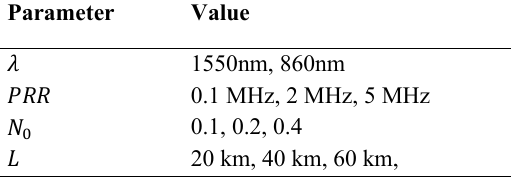
Simulation study input